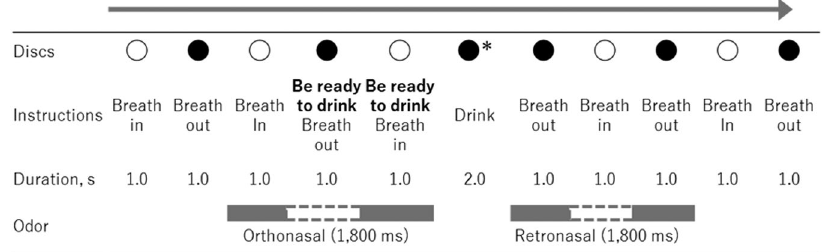
Figure 2. Time course of instruction and discs in taste evaluation phase (Experiment 1). The odor stimulus was presented for a combined maximum of 1.8 s during two successive inhalations or two successive exhalations. The grey bars represent odor delivery; the white gaps represent a pause in odor delivery. * In the actual experiment, we displayed a red disc when participants were instructed to drink the